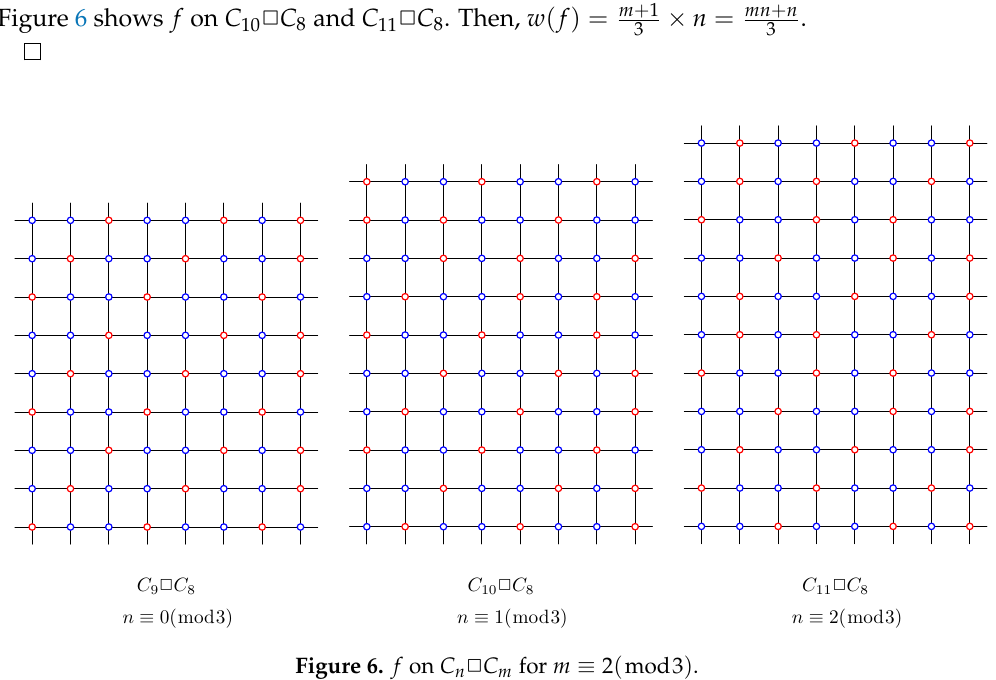
n (cid:50) C m for m ≡ 2 ( mod3 ) .